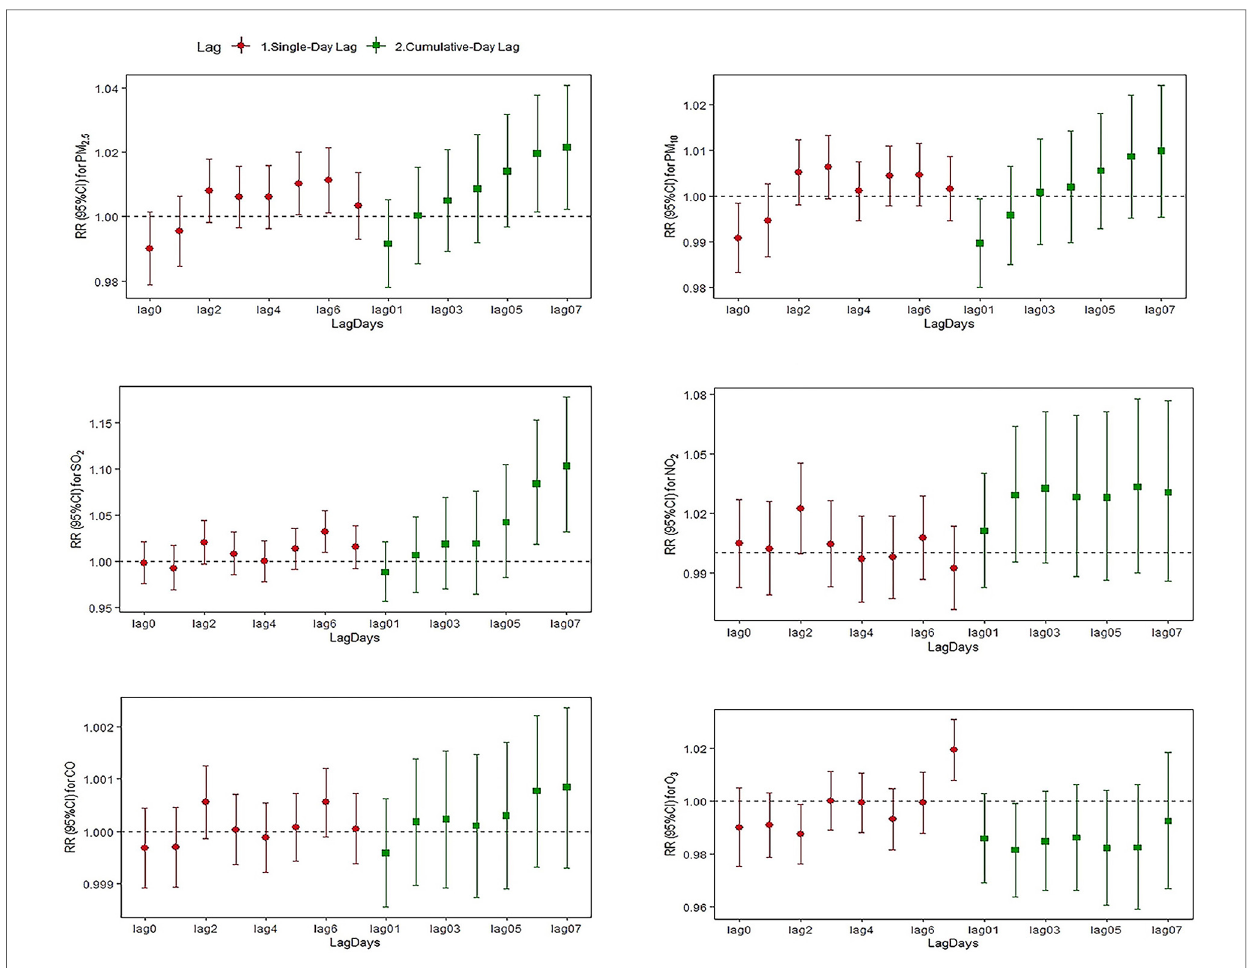
FIGURE 3 Relative risk and 95% CI of hospital admissions for depression at different lag days for every 10 µg/m 3 increase in pollutant